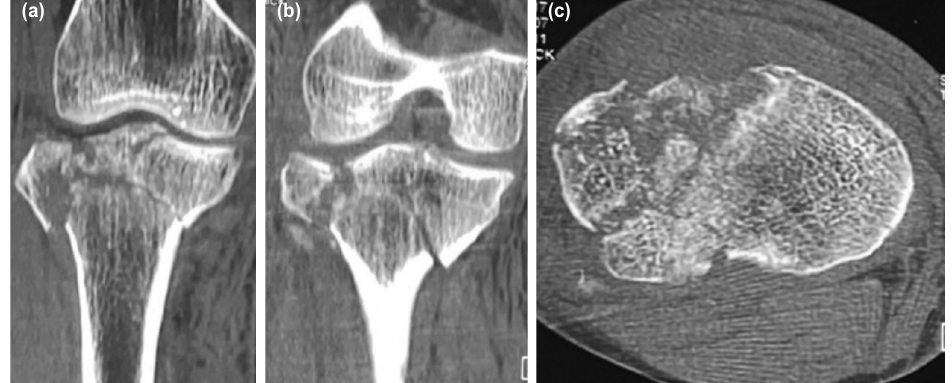
Case No.7, CT images of the knee showing comminution of the proximal tibia. (a) Coronal section image of anterior part of the Fig. 4: tibial condyle. (b) Coronal section image of posterior part of the tibial condyle. (c) Cross-section of the tibial plateau revealing